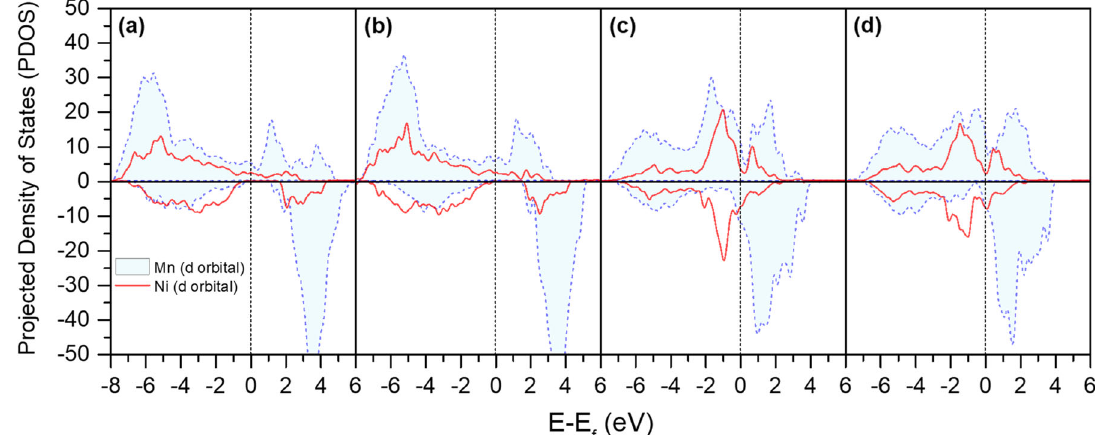
Fig. 5 Projected density of states (PDOS). PDOS of Ni and Mn d-orbitals in the pristine LNMO (003) surface at the delithiation levels of a x = 0 and b x = 0.4, and in the S-substituted LNMO (003) surface at the delithiation levels of c x = 0 and d x = 0.4. The dashed vertical line indicates the Fermi level (E f ).